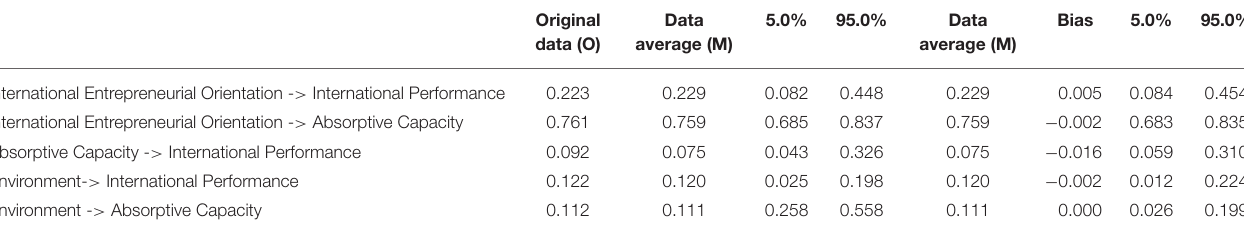
TABLE 8 | HTMT inference .